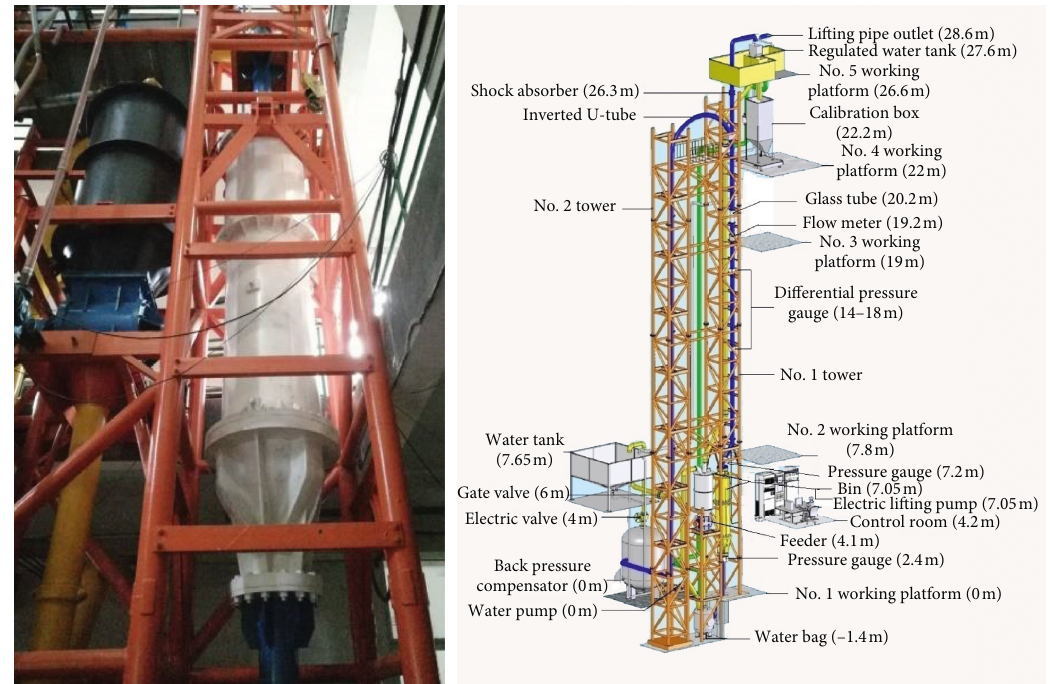
Figure 6: Two-stage electric lifting pump experimental system.